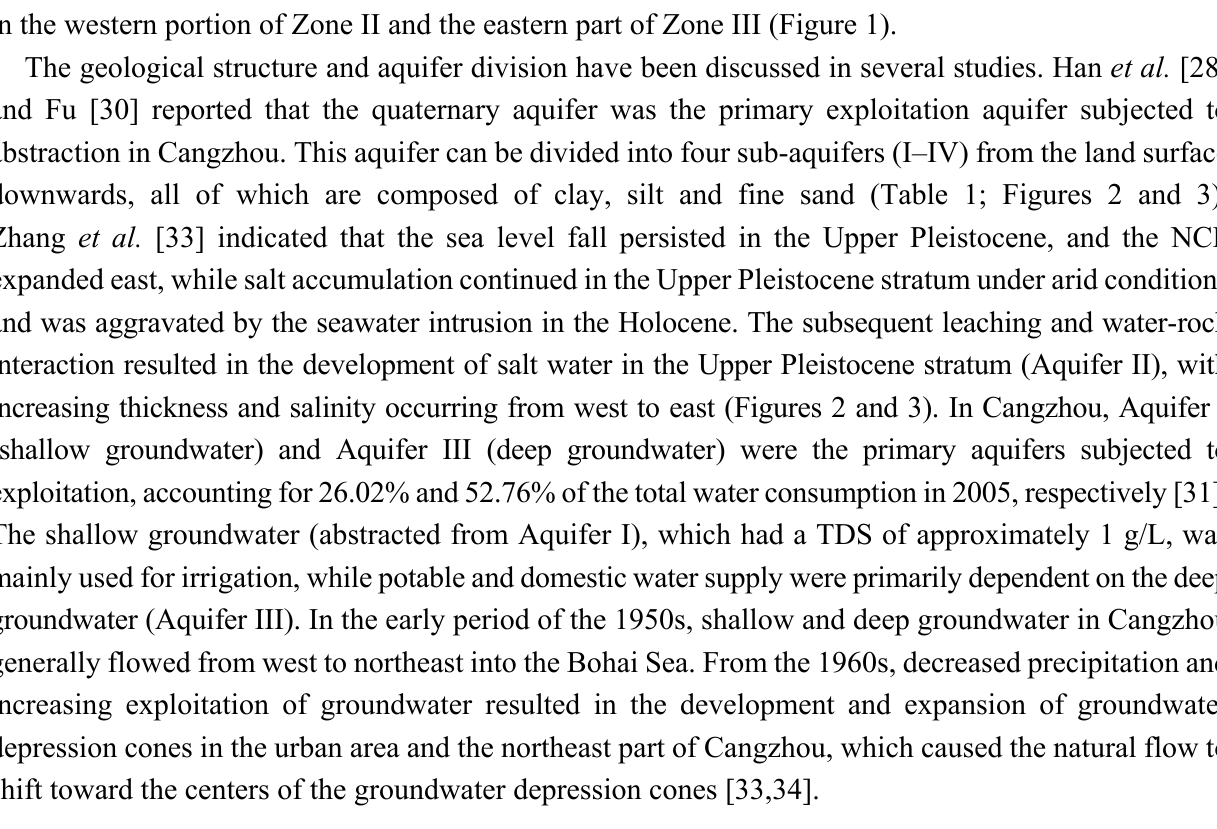
Table 1. Aquifer division and lithology characteristics in